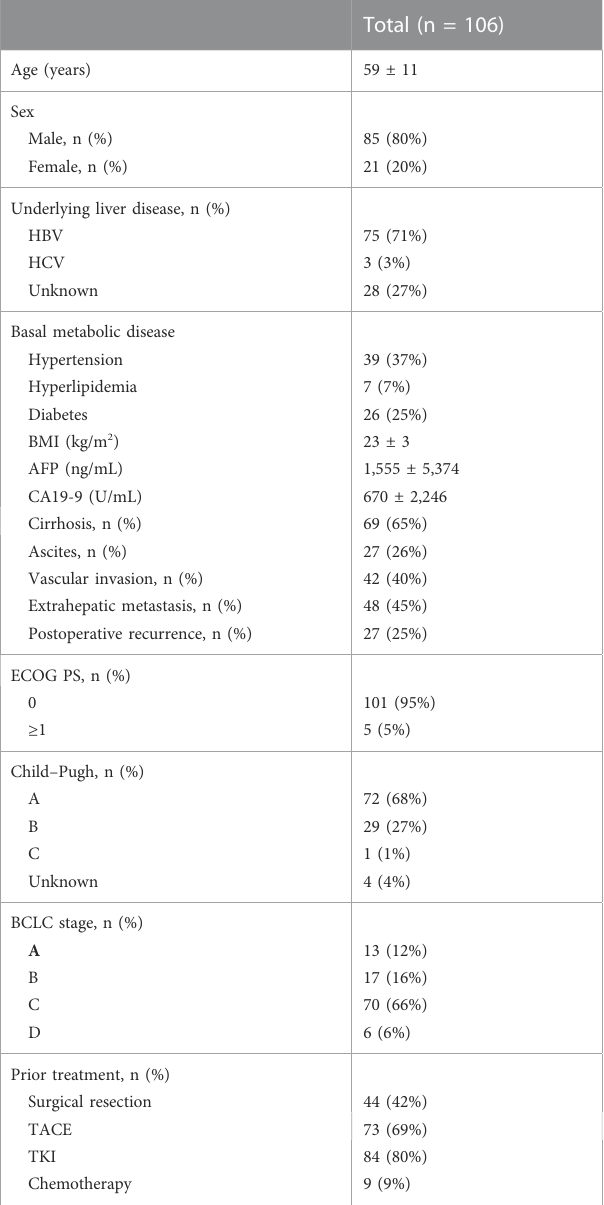
TABLE 1 Baseline characteristics of patients with liver cancer treated with